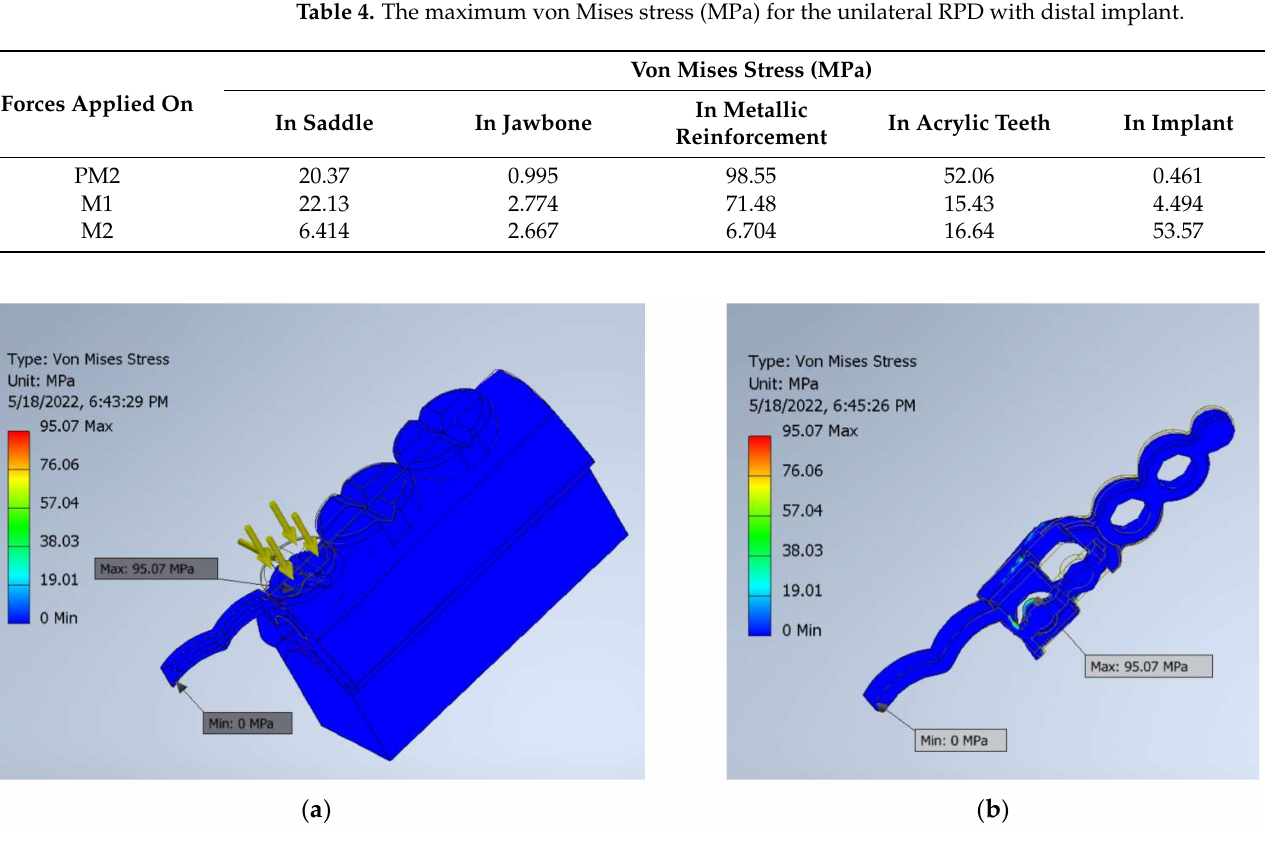
Figure 5. Maximum von Mises stress in classical unilateral RPD when the forces were applied on the PM2: ( a ) full analyzed assembly; ( b ) metallic